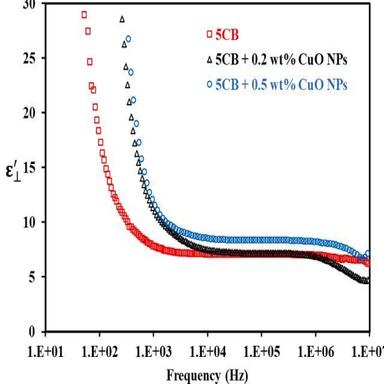
Variation of transverse component of permittivity (ε ′ ⊥) with frequency for pure and dispersed samples at 24 ◦C. Pure 5CB (squares), 5CB + 0.2 wt% CuO NPs (triangles) and 5CB + 0.5 wt% CuO NPs (Circles) represents.